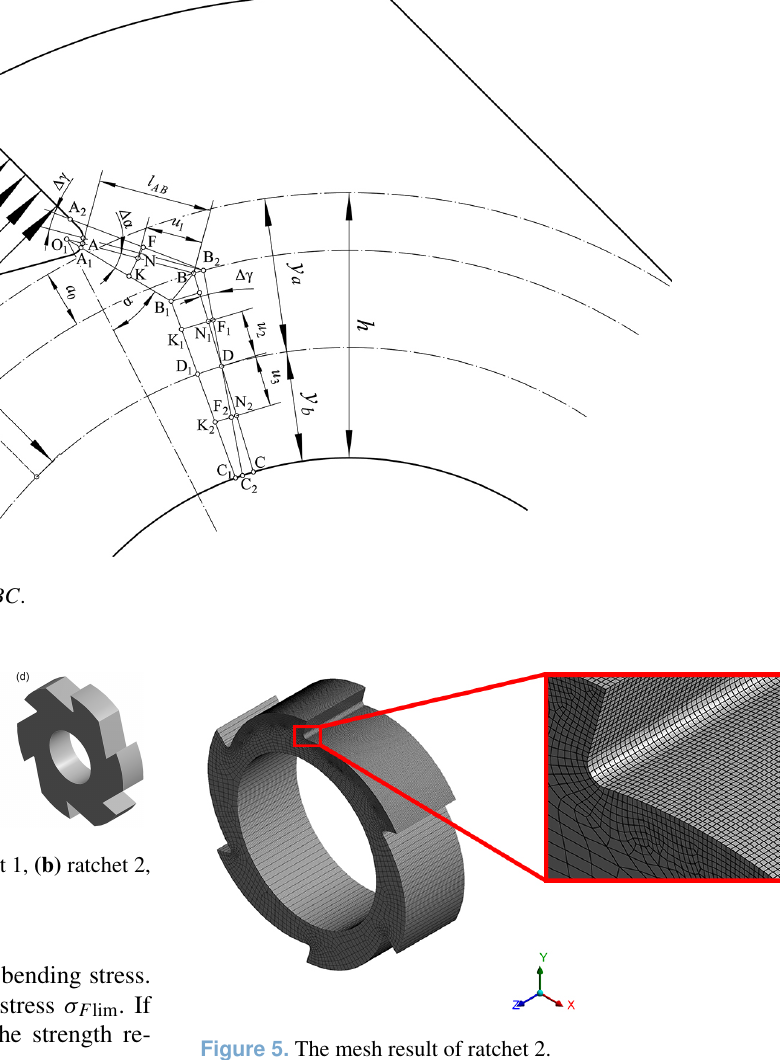
Figure 5. The mesh result of ratchet